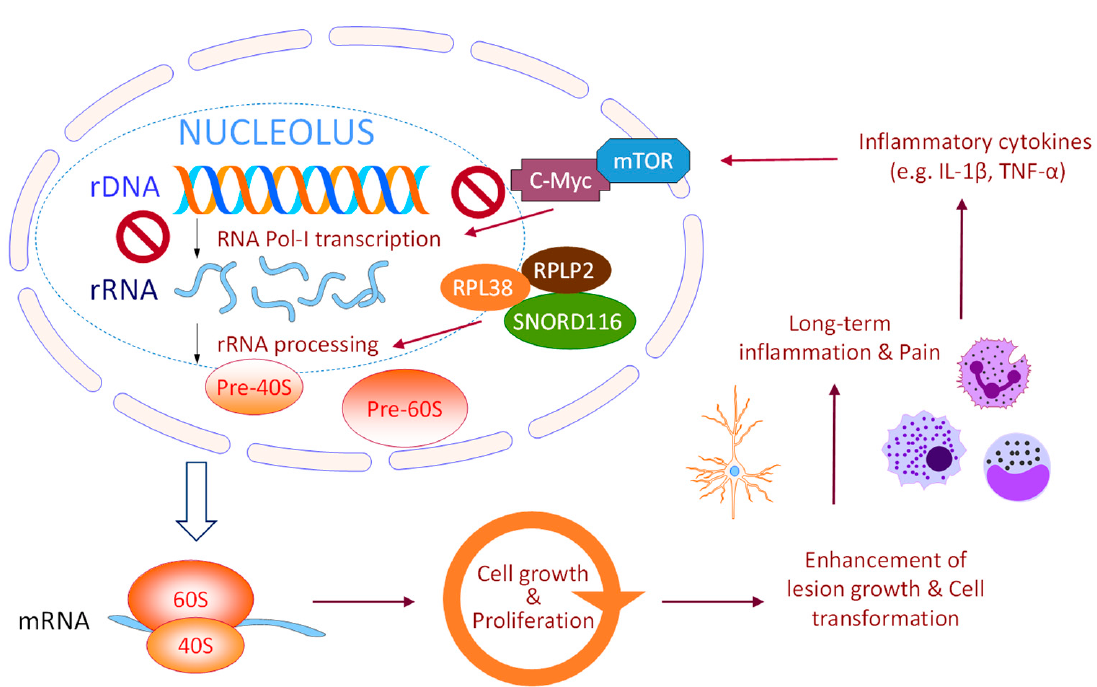
Figure 7. Ribosome biogenesis serves as a therapeutic target for treating endometriosis. The ribosome biogenesis machinery in cells determines energy homeostasis, which is critical to maintain cell growth and proliferation. Endometriosis-induced inflammatory cytokines, e.g., IL-1 β and TNF- α , can activate PI3K/AKT/mTOR signaling [34], which subsequently promotes RNA polymerase I-mediated rRNA transcription and editing/processing, resulting in continuous cell growth. Development of endometriotic lesions in peritoneal cavity triggers long-term inflammation and neuron fiber formation, leading to chronic pelvic pain. Up-regulation of ribosome biogenesis by endometriosis-related effectors, such as SNORD116, RPLP2 and RPL38 [12], may speed up the whole process and provide sufficient energy for further aggressive progression. Blockage of ribosome biogenesis by inhibitors against PI3K/mTOR or RNA polymerase-1 can cause genometoxic shock due to energy shortage and ribosomal protein imbalance, leading to cell cycle arrest and apoptosis via p53/p21 pathway.